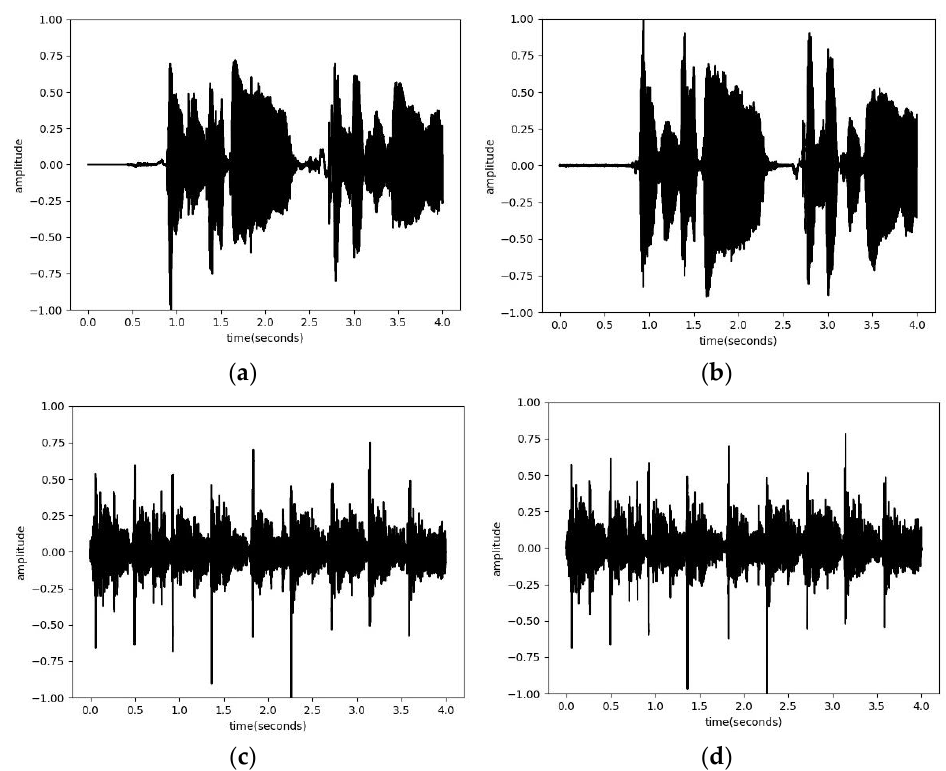
Figure 7. Comparison of waveforms before and after separation. ( a ) Primitive vocal waveform; ( b ) separated vocal waveform; ( c ) primitive accompaniment waveform; ( d ) separated accompaniment waveform. Table 2. Training model parameter